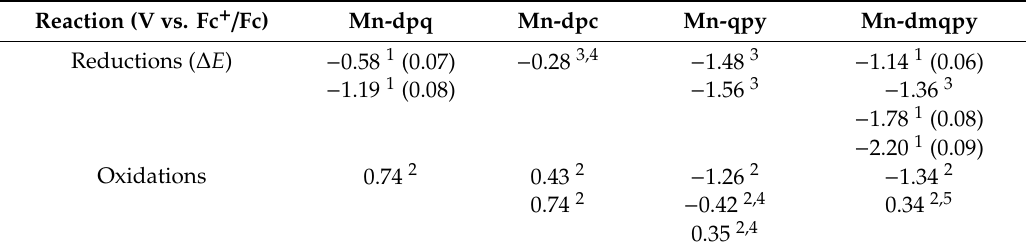
Table 3. Electrochemical data in aprotic media for the Mn(I) complexes.